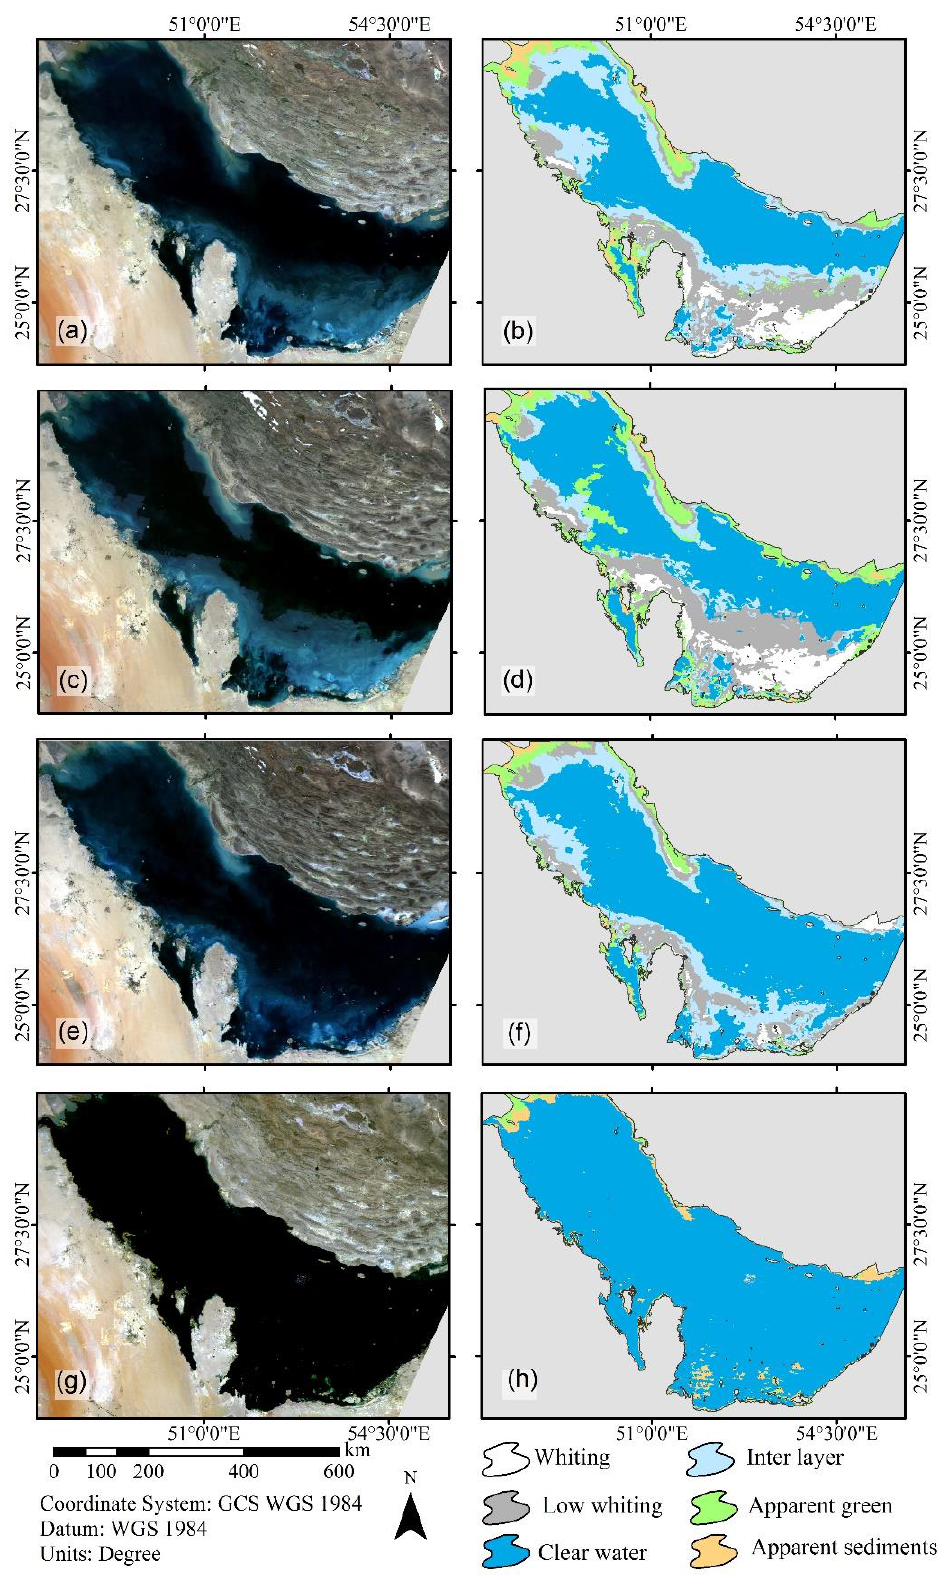
Figure 8. MODIS images and their classification results: ( a , b ) 2 March 2003, ( c , d ) 4 March 2012, ( e , f ) 10 February 2016 and ( g , h ) 3 October 2018.